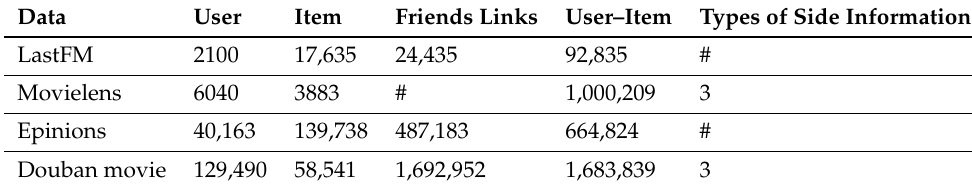
Table 2. Statistics of datasets used in this